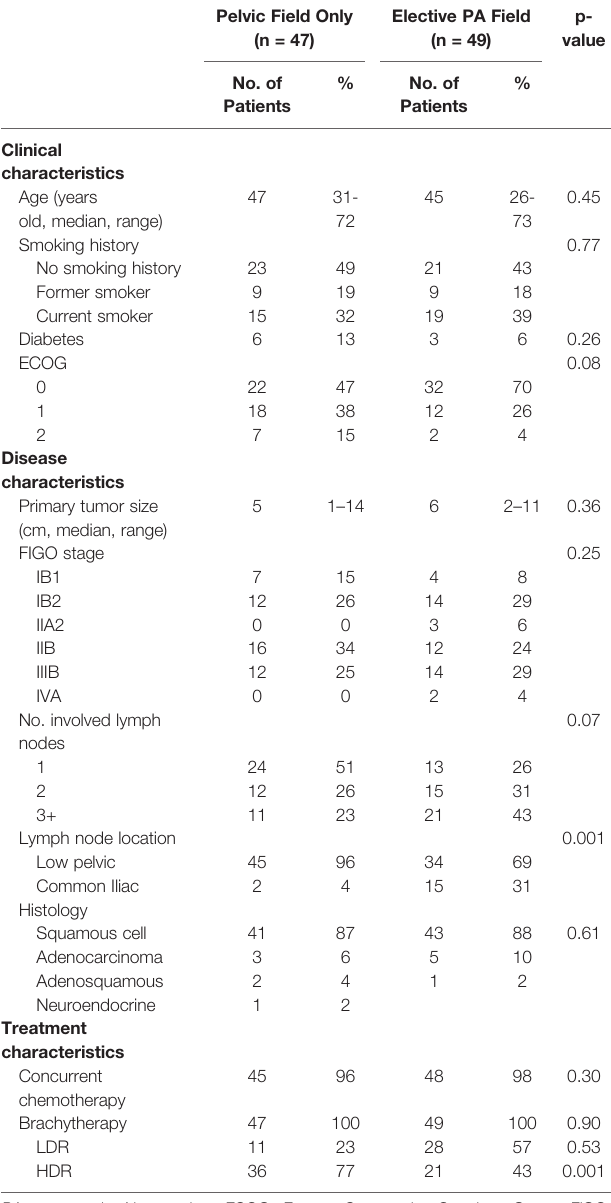
TABLE 1 | Clinical, disease, and treatment characteristics of 96 patients with node positive cervical cancer treated with de fi nitive intent radiation. Pelvic Field Only Elective PA Field (n = 47) (n =